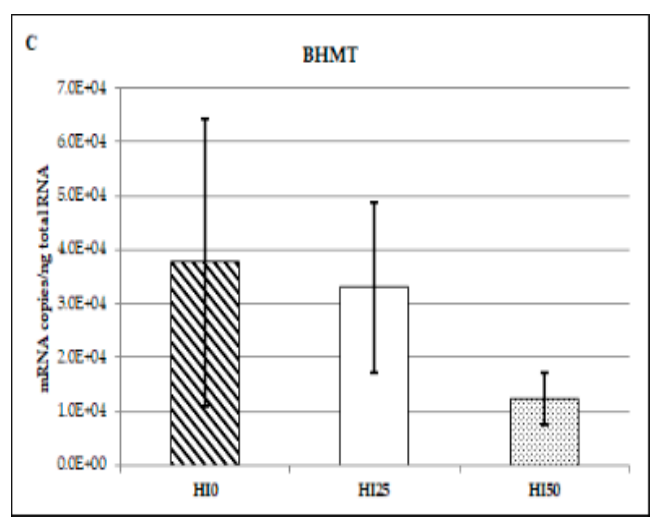
Figure 1. (A–C). Transcript copies of genes coding for CBS , SAHH , and BHMT enzymes in the liver of rainbow trout fed a control diet with no inclusion of HI meal and two other diets with 25% (HI25) and 50% (HI50) inclusion. Different letters indicate significant differences ( p < 0.05). Data represent the mean ± s.d. (n = 8).